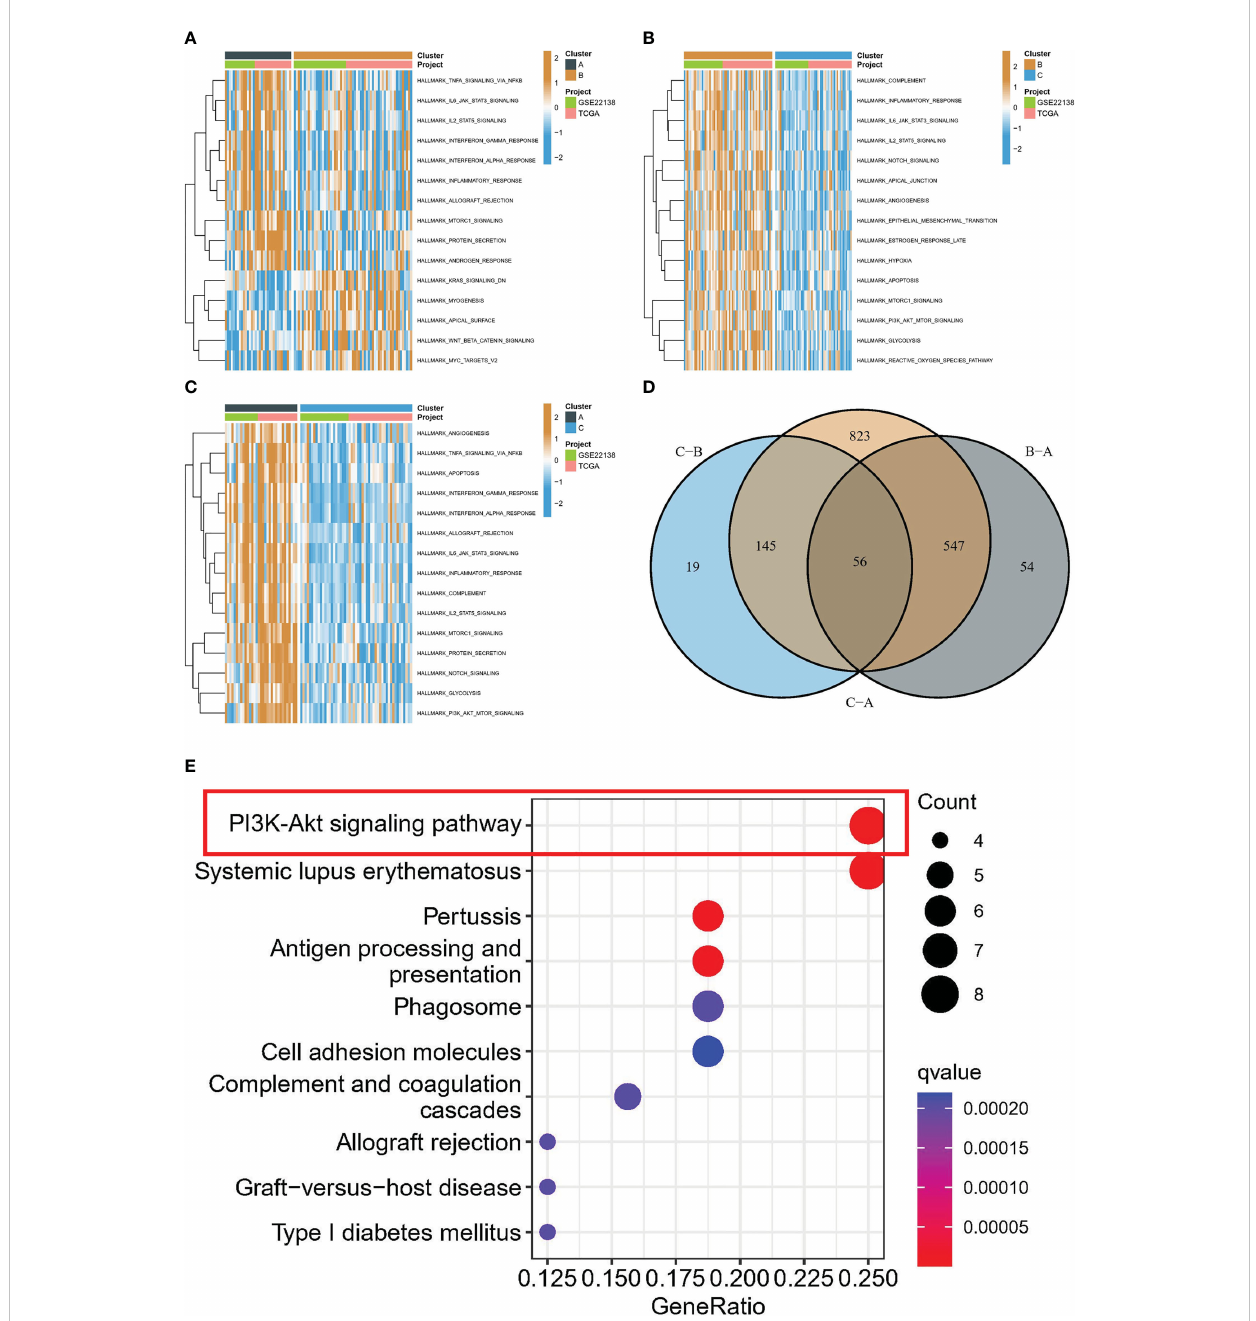
FIGURE 4 Biological characterization of molecular subtypes. (A-C) The GSVA pathway enrichment analysis between different subtypes. (D) Venn diagram of molecular subtype-associated DEGs. (E) KEGG